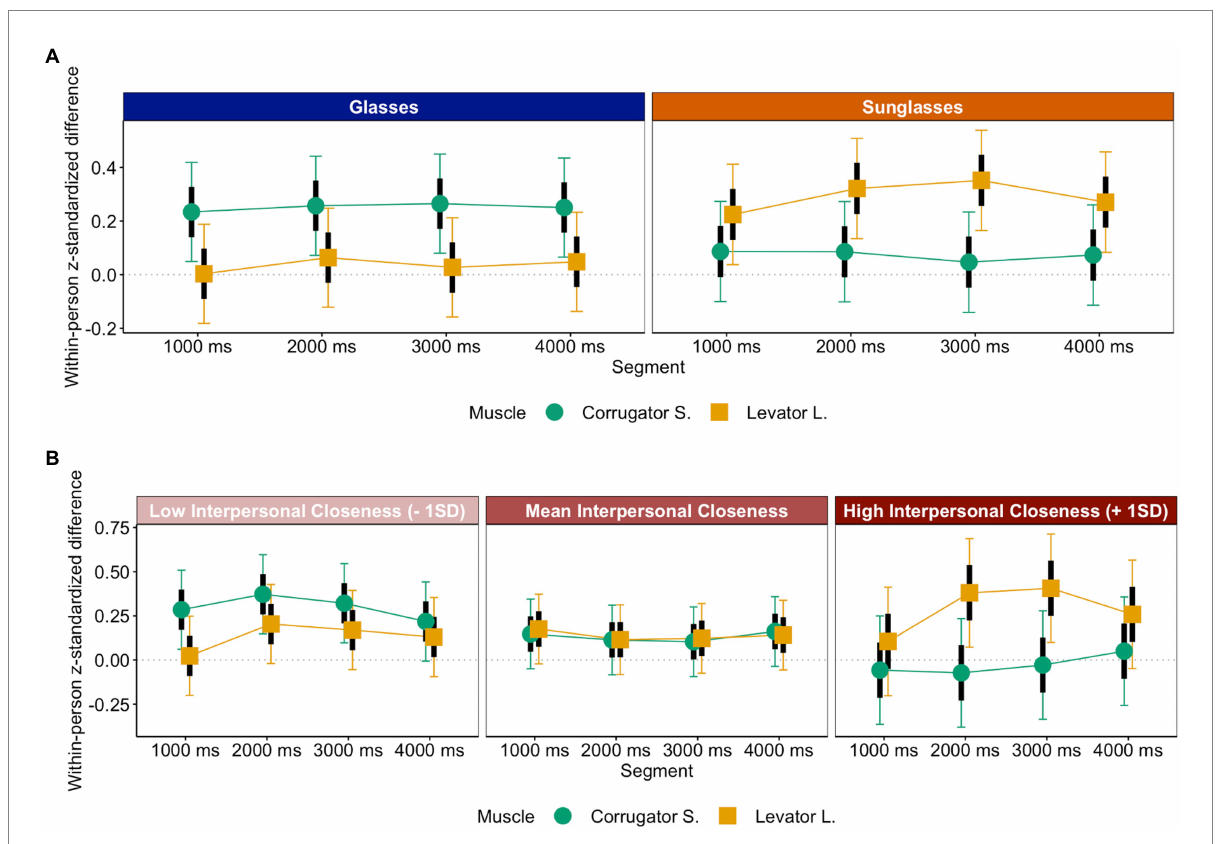
FIGURE 9 Disgust mimicry as a function of eye contact, segment and muscle (A) and interpersonal closeness, segment and muscle (B)